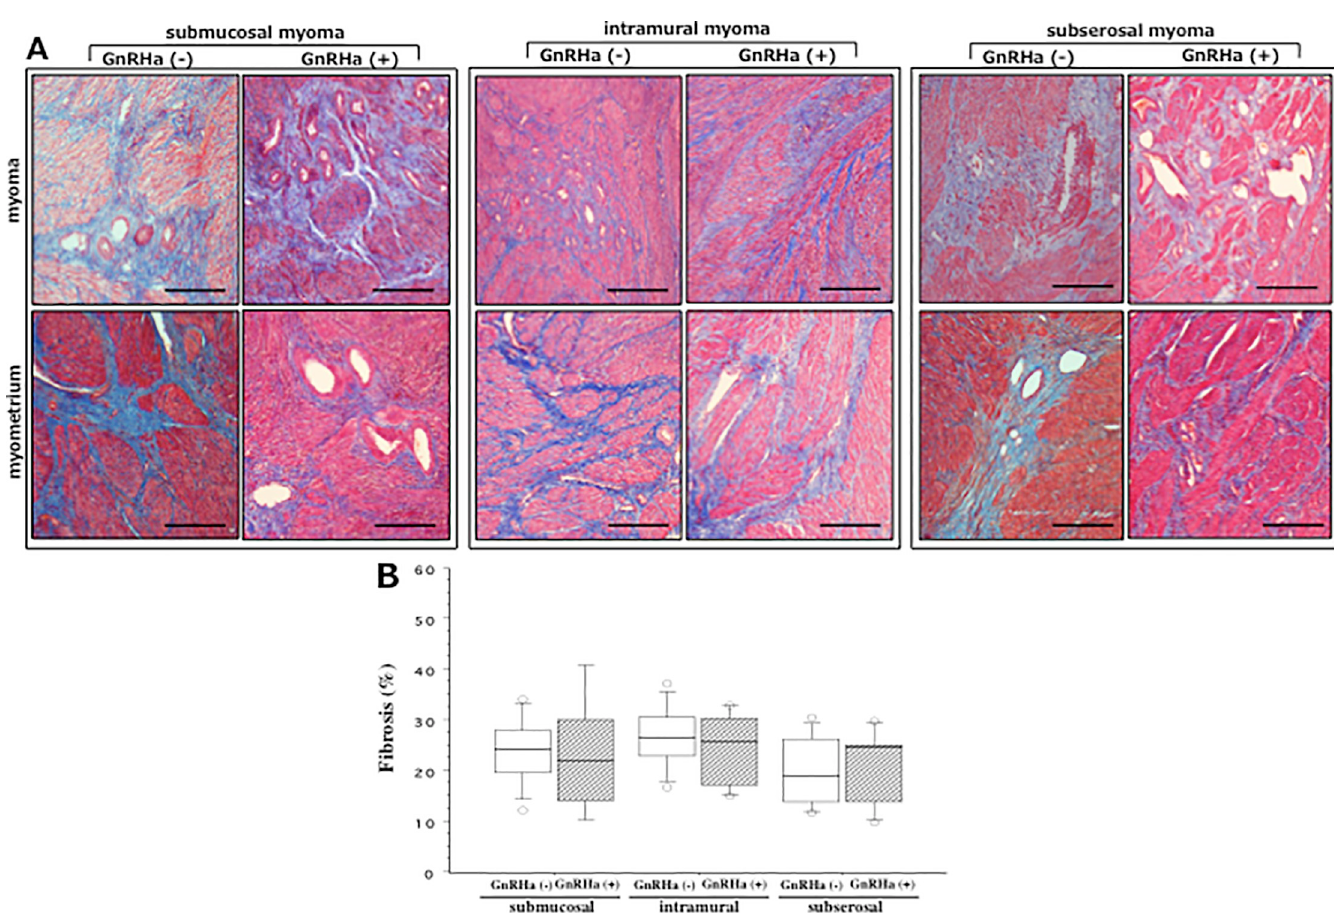
Fig 6. (A) Masson’s trichrome (MT)-stained fibrosis in the biopsy samples derived from myoma (upper row) and myometria (lower row) of GnRHa-treated (GnRHa+, hatched box) and GnRHa-untreated (GnRHa-, white box) women with submucosal myoma (SMM, left column), intramural myoma (IMM, middle column) and subserosal myoma (SSM, right column). Scale bar = 50 μ m for each slide. (B) Computer-captured image analysis of fibrosis in combined myoma and myometria indicated that there was no significant difference in the percentage of fibrosis between GnRHa (-) and GnRHa (+) group of women with SMM, IMM and SSM. The boxes represent the interquartile ranges and horizontal lines in the boxes represent median